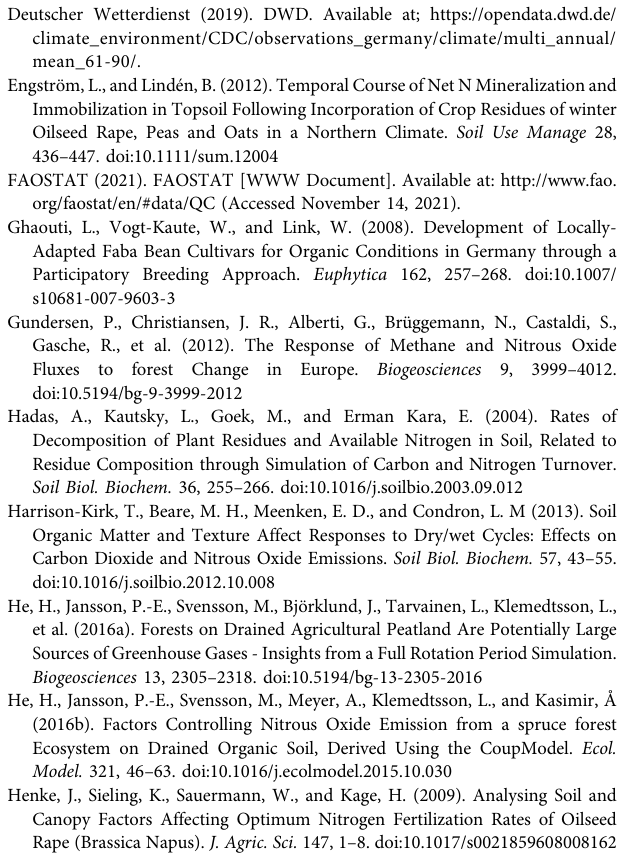
Supplementary Figure S1 | Measured and simulated soil respiration from non- fertilized soils (No fert) and soils fertilized with 90 kg N ha -1 (Fert-90) or 180 kg N ha -1 (Fert-180) in spring. In all soils straw was quanti fi ed and placed back in the respective fertilized soils (+str). Sampling period was from August 2013 to March 2014 and August 2014 to March 2015. Numbers above the panel describe the quality of the COUP model for the respective fertilizertreatment. Error bars showthe standard error of mean of each treatment ( n (cid:2)